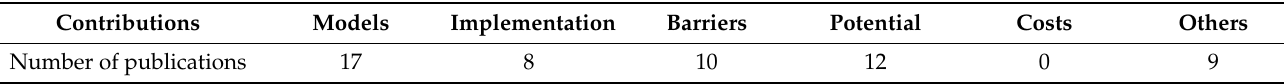
Table 3. Trend of research on demand response in